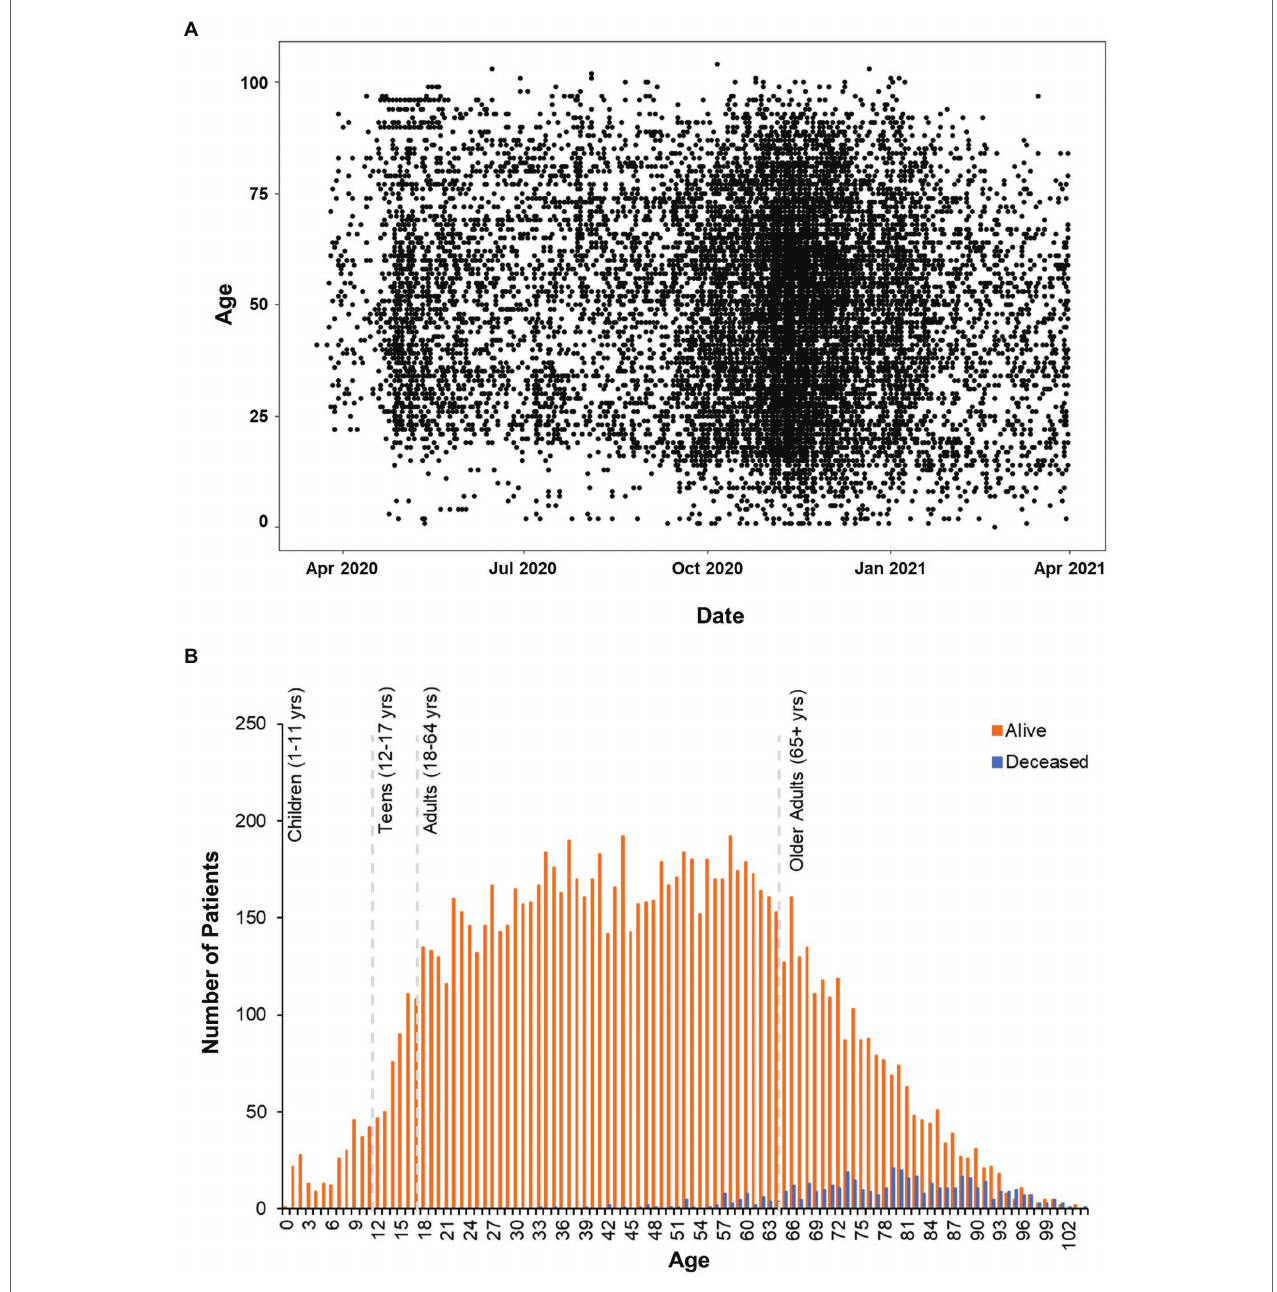
of particular interest given its high prevalence in our dataset ( Figure 4A ) and across the United States. Further analysis of the deceased patients revealed that the proportion of individuals with diabetes is greater than would be expected [ χ 2 (1) =